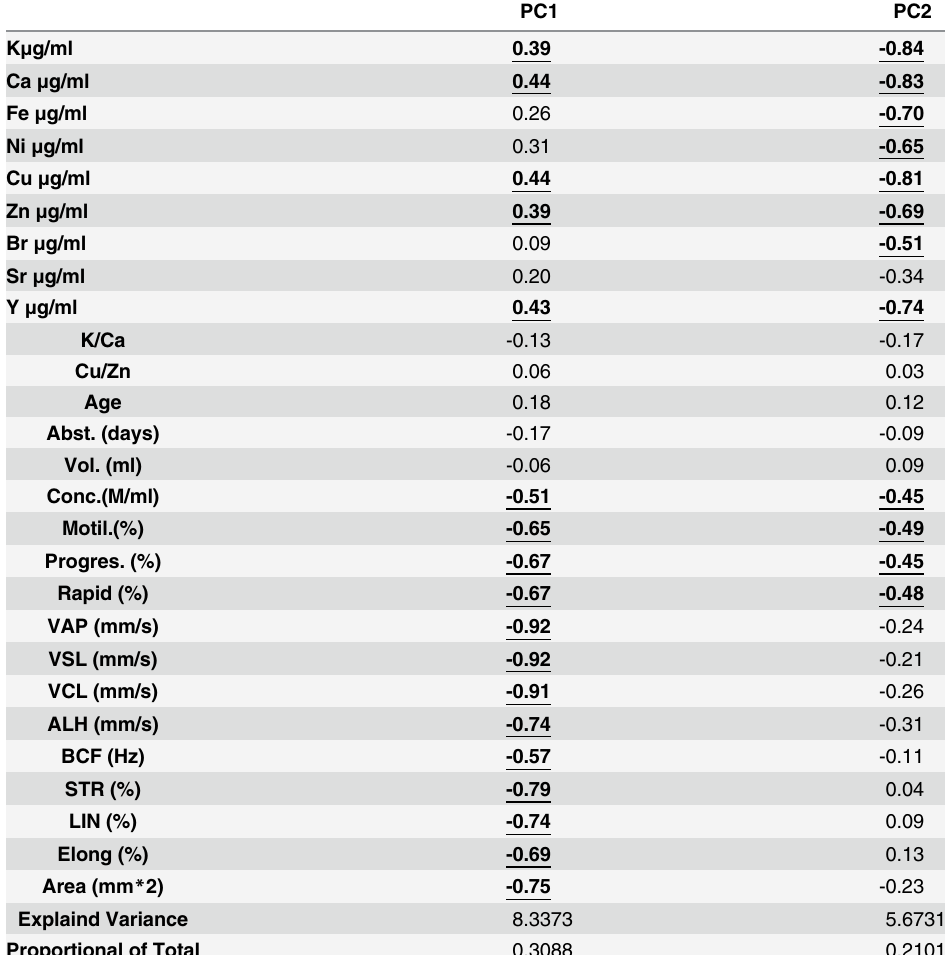
Table 3. The absolute contributions of variables to selected PC axes; (marked loadings (cid:1)